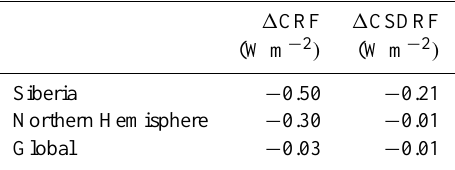
Table 3. Simulated changes in radiative effects due to change in BVOC emission between years 2000 and 2100, averaged over Siberian domain, Northern Hemisphere, and globally. CRF is cloud radiative forcing; CSDRF is direct aerosol effect, which accounts only for clear-sky short-wave